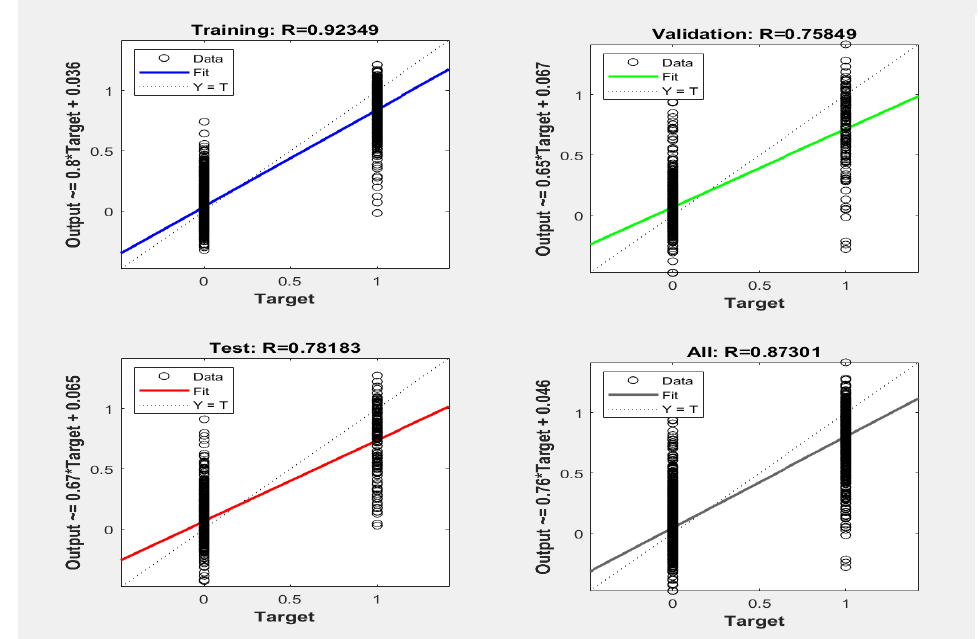
Figure 13. The training gradient displays of the ANN algorithm considering the datasets used. ( a ) The ISIC 2018 dataset. ( b ) The PH2 dataset.